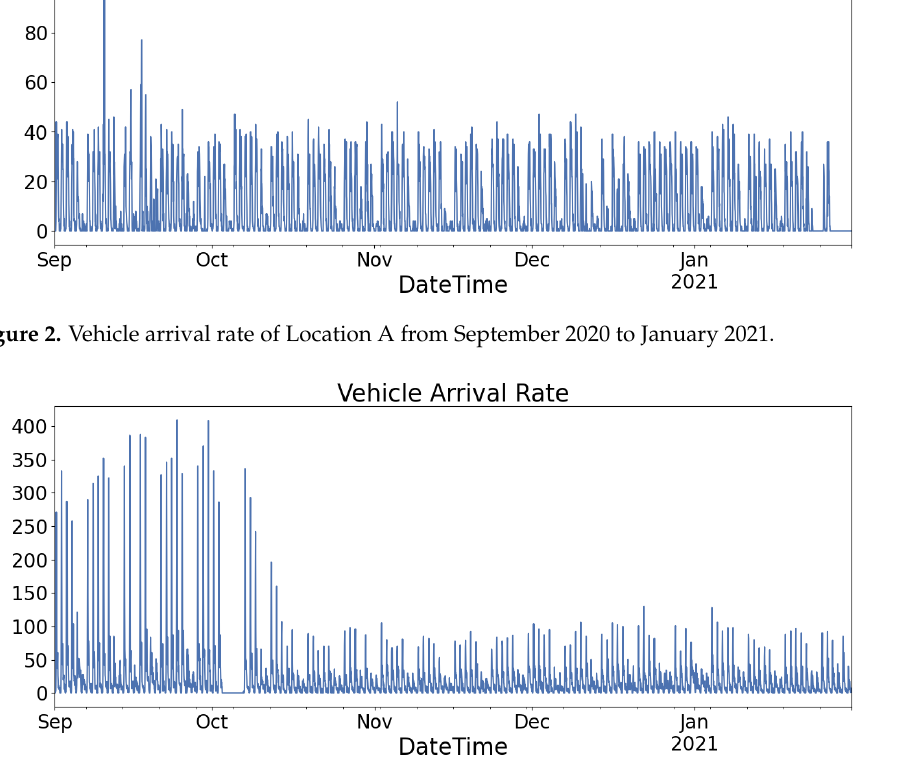
Figure 3. Vehicle arrival rate of Location B from September 2020 to November